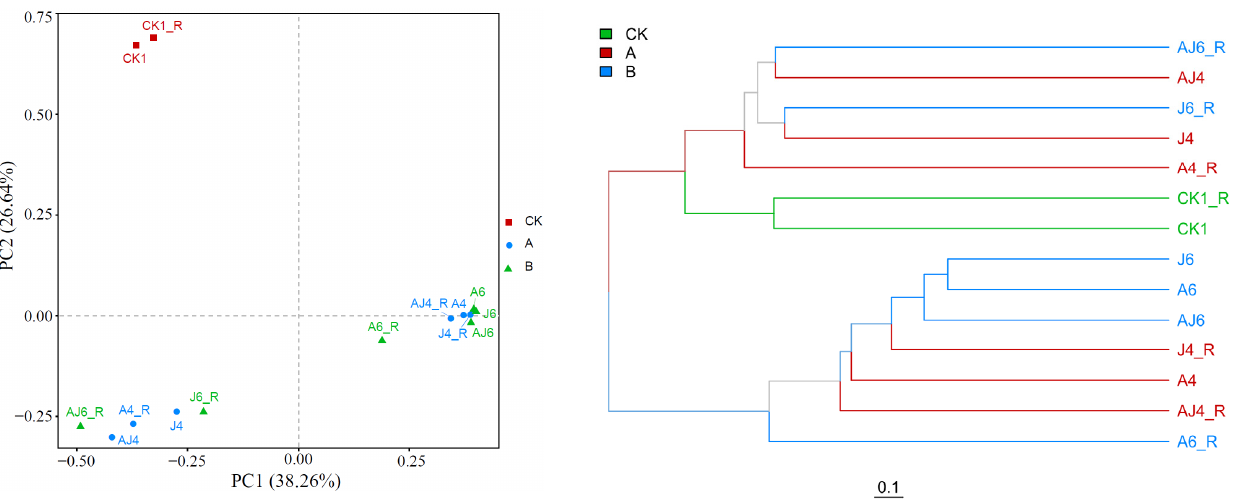
Figure 6. PCA diagram and clustering tree diagram under different processing conditions based on OUTs (group A represents each experimental group on the 56th day of the experiment, and group B represents each experimental group on the 84th day of the experiment).